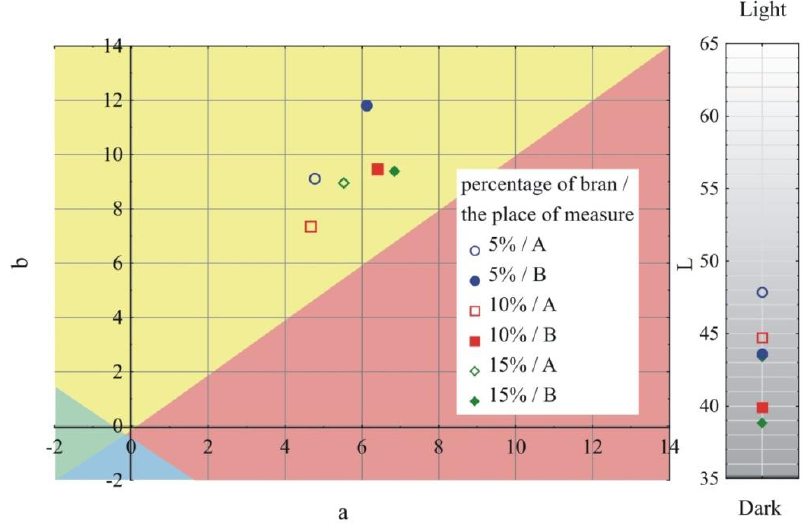
Figure 3. Variability of the color parameters L, a, b of injection mouldings depending on the content of the mass fraction of bran and grain size 0.4–0.6 mm at measuring points A and B (position of measuring points marked in Figure 1).